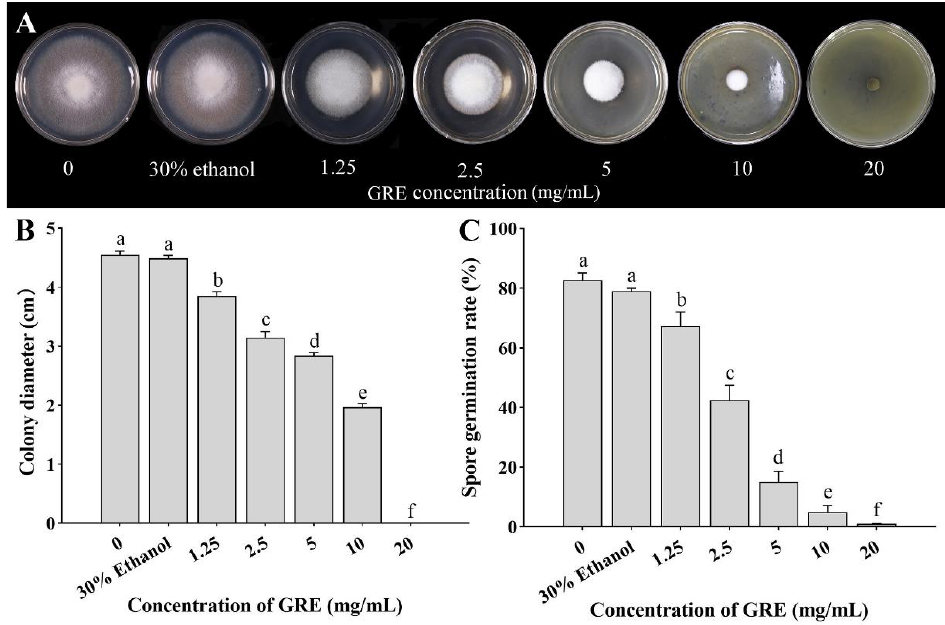
Figure 1. Effects of different concentrations of GRE on F. solani growth. ( A ) Colony morphology after 5 days of treatment. ( B ) Colony diameter after 5 days of treatment. ( C ) Spore germination rate after 6 h of treatment. The bars on the columns represent standard deviations, and different letters above the bars represent significant differences ( p < 0.05).